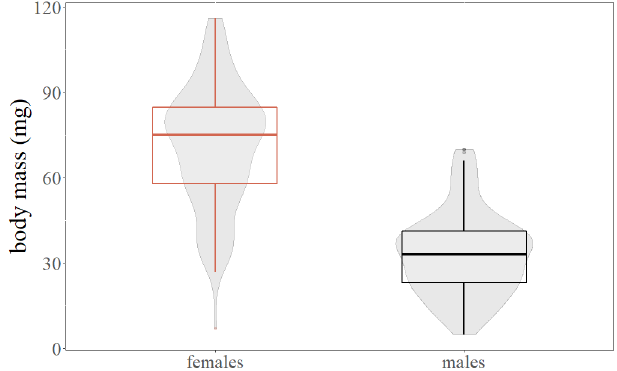
(black) of P . denticulatum